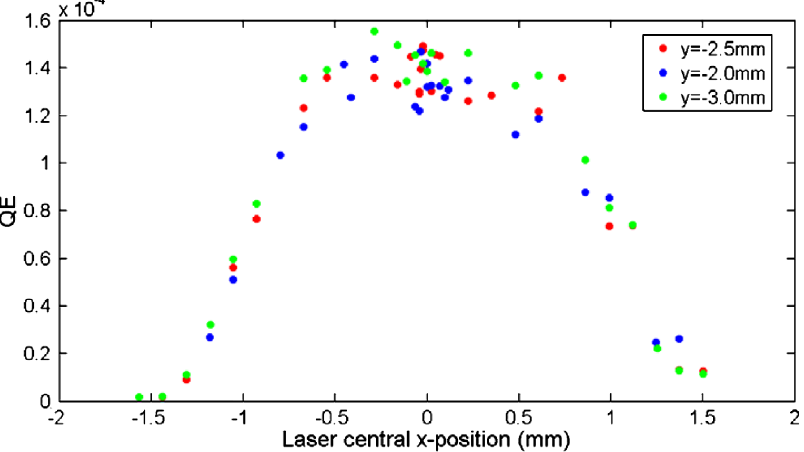
5. The QE measured eight months following laser cleaning, for area B, using a 1-mm-diameter laser spot size. The area has a (cid:2) 2 : 5 mm y offset from the cathode center. Within (cid:5) 0 : 5 mm of the central x location, the full laser spot was located within the cleaned area, while it was located completely outside the cleaned area for a central x location beyond þ 1 : 5 mm or (cid:2) 1 : 5 mm . For central x